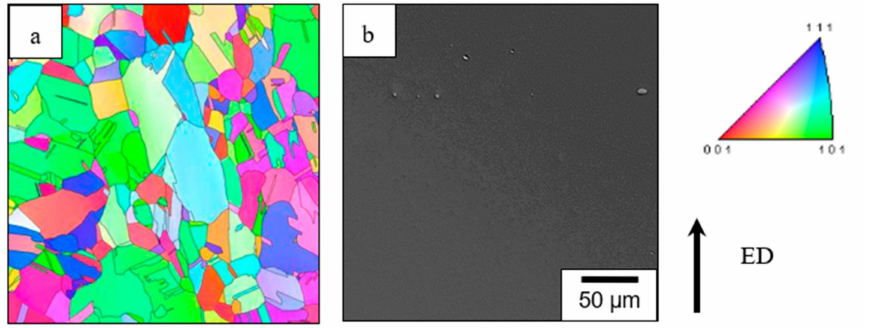
Figure 1. ( a ) Typical orientation imaging microscopy (OIM) map and ( b ) back-scattered electron (BSE) image of the annealed Cu rod (longitude section).